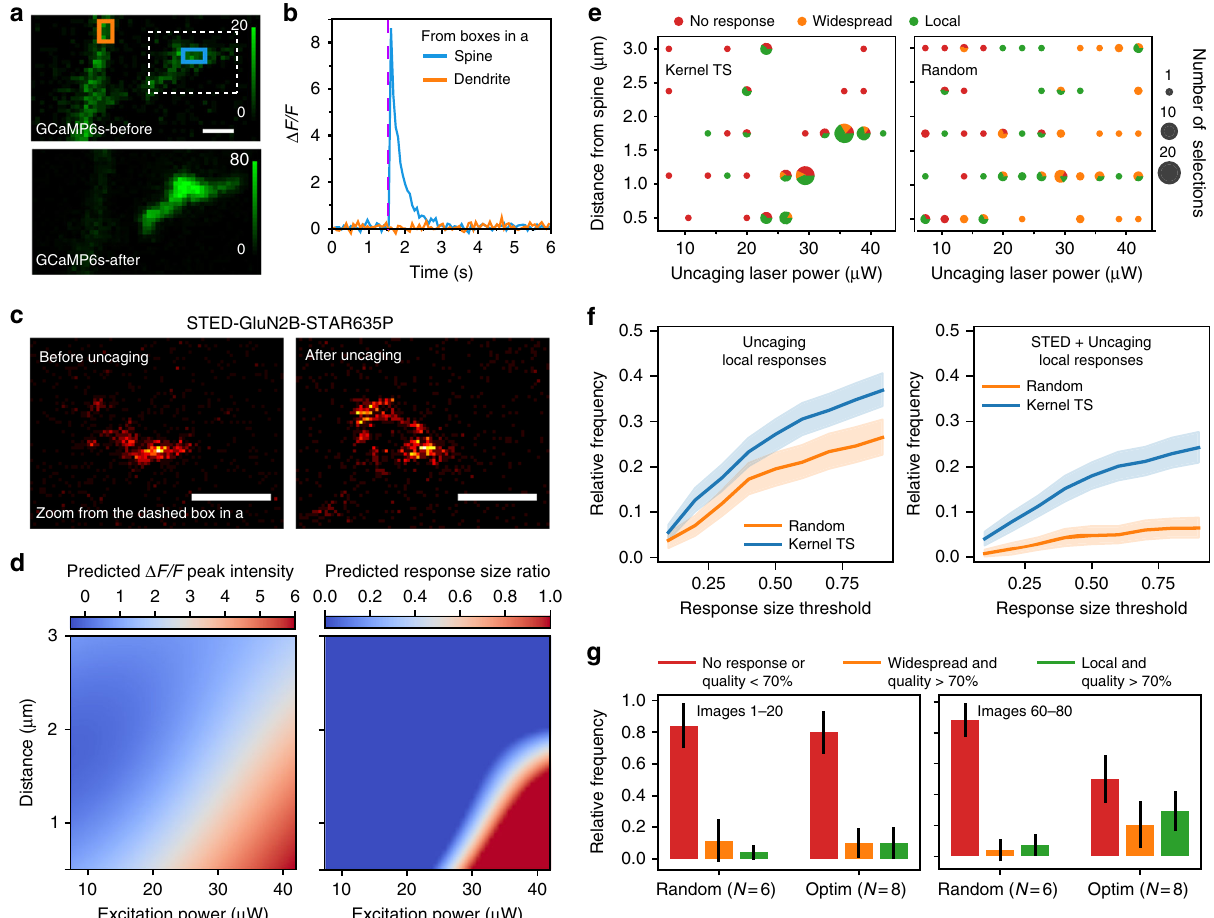
Fig. 4 Multimodal optimization in living cells. a GCaMP6s fl uorescence before and after glutamate uncaging. b Change in Ca 2 + concentration inside the ROIs in spine (cyan rectangle in a ) and dendrite (orange rectangle in a ). Ca 2 + response was limited to the spine. c GFP-GluN2B tagged with FluoTag-X4 anti-GFP STAR635P before and after uncaging (zoomed inset from the dotted box in a ). Scale bars 500 nm. d Objective functions, i.e. Δ F / F peak intensity (left) and response size ratio (right), predicted by kernel regression after 80 observations. The colorbar indicates the predicted value for this objective, in the objective units. e Types of Ca 2 + responses after glutamate uncaging for the selected parameters during one optimization (left) and random sampling (right) trials. Pie charts show the repartition between response types, i.e. local (green), widespread (orange) and no response above threshold (red). The size of each pie chart is proportional to the number of trials of the parameter con fi guration. f Relative frequency of local response ratios over all images obtained in several trials of 80-image sequences, for different response size ratio threshold values. 95% con fi dence intervals are obtained by 1000 bootstrap repetitions. g Comparison of the success rate of multimodal experiments using RS and Kernel TS for the images 1 – 20 and 60 – 80. Vertical bars indicate one standard deviation computed over the N repetitions. With Kernel TS, a signi fi cant increase in the frequency of local responses and decrease in the no-response rate are observed between the fi rst and the last images (Kruskal − Wallis, p = 0.01 and p = 0.004 respectively), with RS no signi fi cant difference in the frequency of local response and no-response rate was observed between the fi rst and the last images (Kruskal − Wallis, p = 0.45 and p = 0.57 respectively). e , g The threshold for the response size ratio was set to